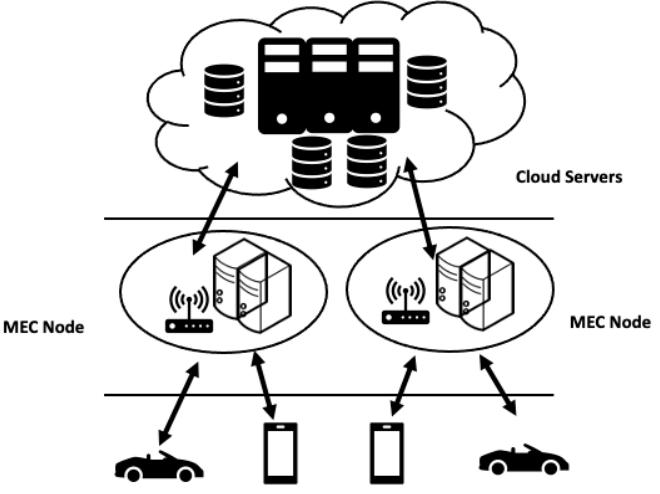
Figure 2. Multi-access edge computing architecture.